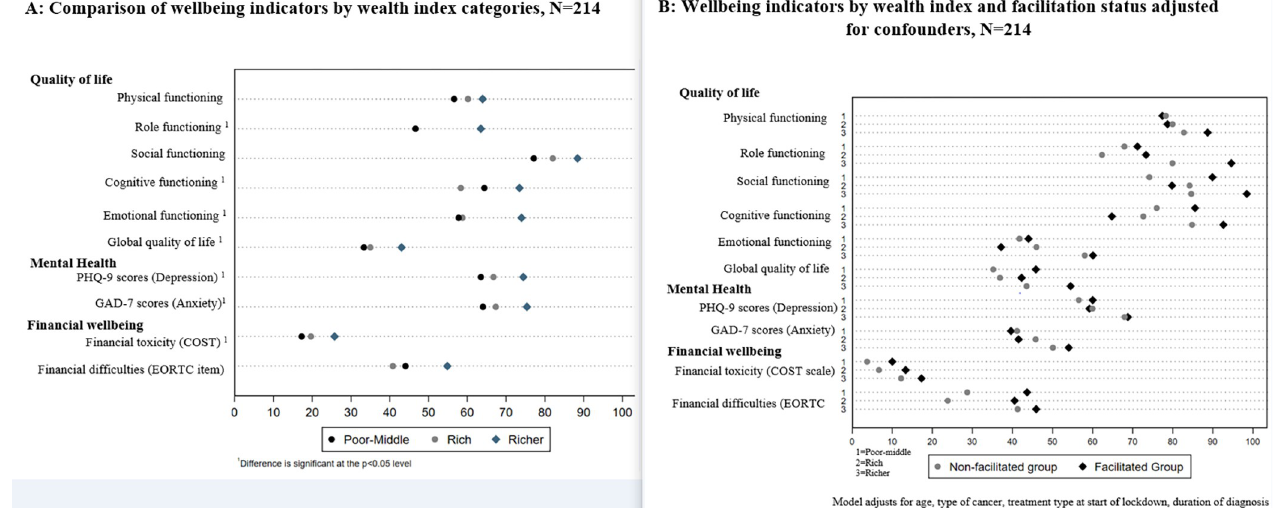
Fig 3. Comparison of wellbeing indicators by wealth index and facilitation status for crude and adjusted models, N = 214.